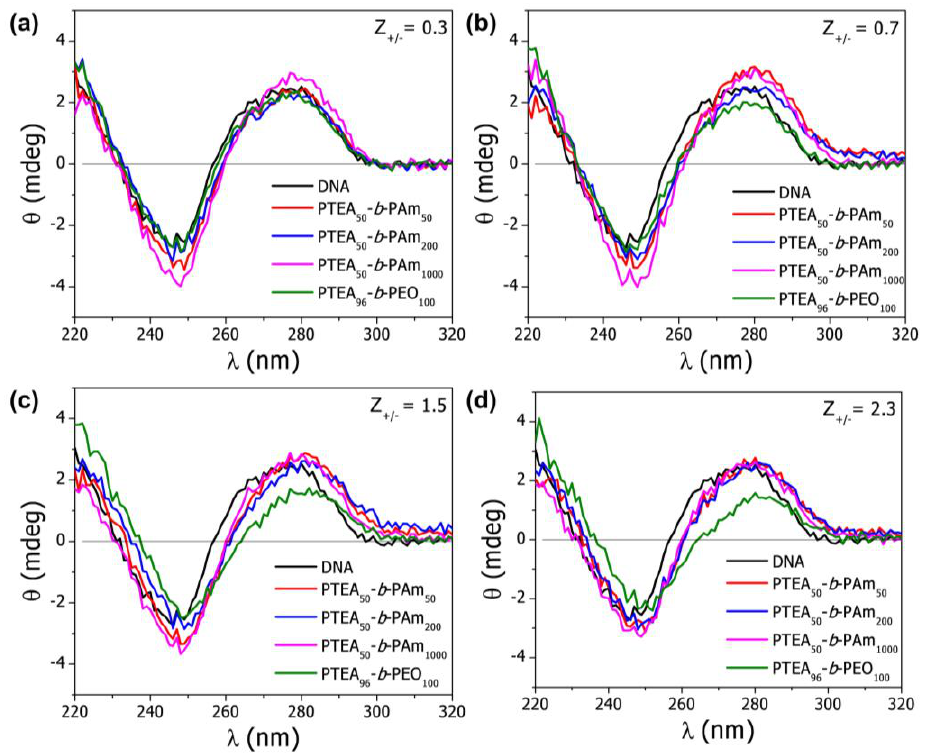
Figure 6. CD spectra of 0.4 mM DNA titrated with (PTEA) 50 - b -(PAm) 50 , (PTEA) 50 - b -(PAm) 200 , (PTEA) 50 - b -(PAm) 1000 , or (PTEA) 96 - b -(PEO) 100 with DNA at ( a ) Z +/- = 0.3, ( b ) Z +/- = 0.7, ( c ) Z +/- = 1.5, and (d) Z +/- = 2.3.